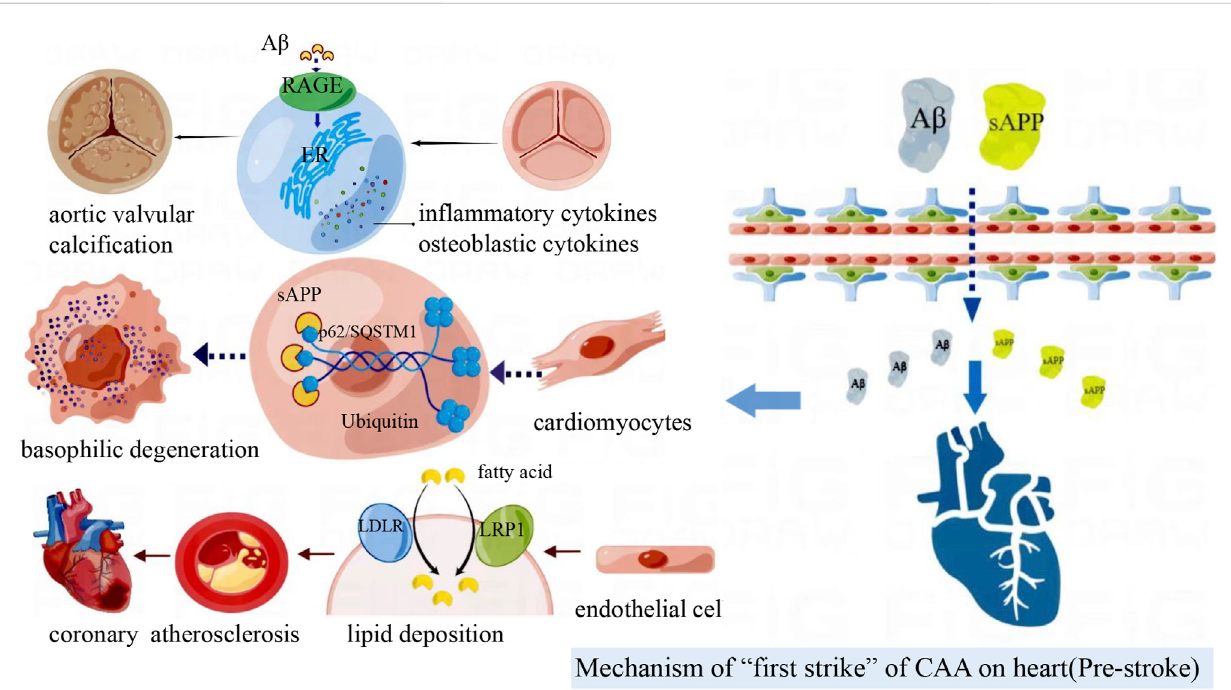
FIGURE 3 Amyloid deposited in the brain can cross the blood-brain barrier to reach the peripheral vasculature and heart. A β deposition in blood vessels accelerate coronary atherosclerosis; A β induces aortic valve interstitial cell osteogenesis, and then calci fi c aortic valve disease (CAVD) occurs. sAPP associates with p62/SQSTM1-ubiquitin to form inclusion bodies in cardiomyocytes and participates in basophilic